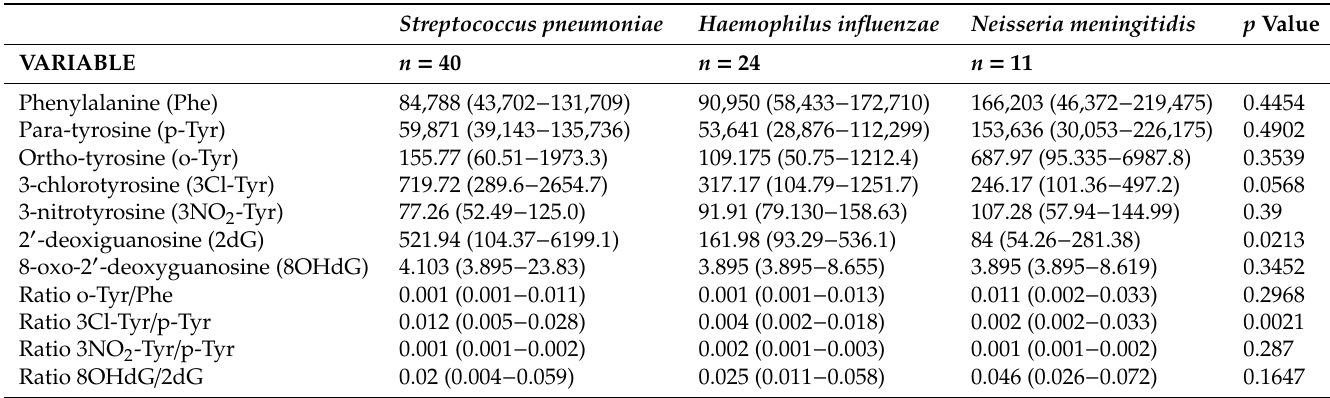
Table 4. Comparison of the admission median cerebrospinal fluid (CSF) concentrations (IQR) in nmol / L of markers of ROS / RNS-mediated stress to proteins, DNA and inflammation in children with di ff erent etiologies of bacterial meningitis. Kruskal-Wallis